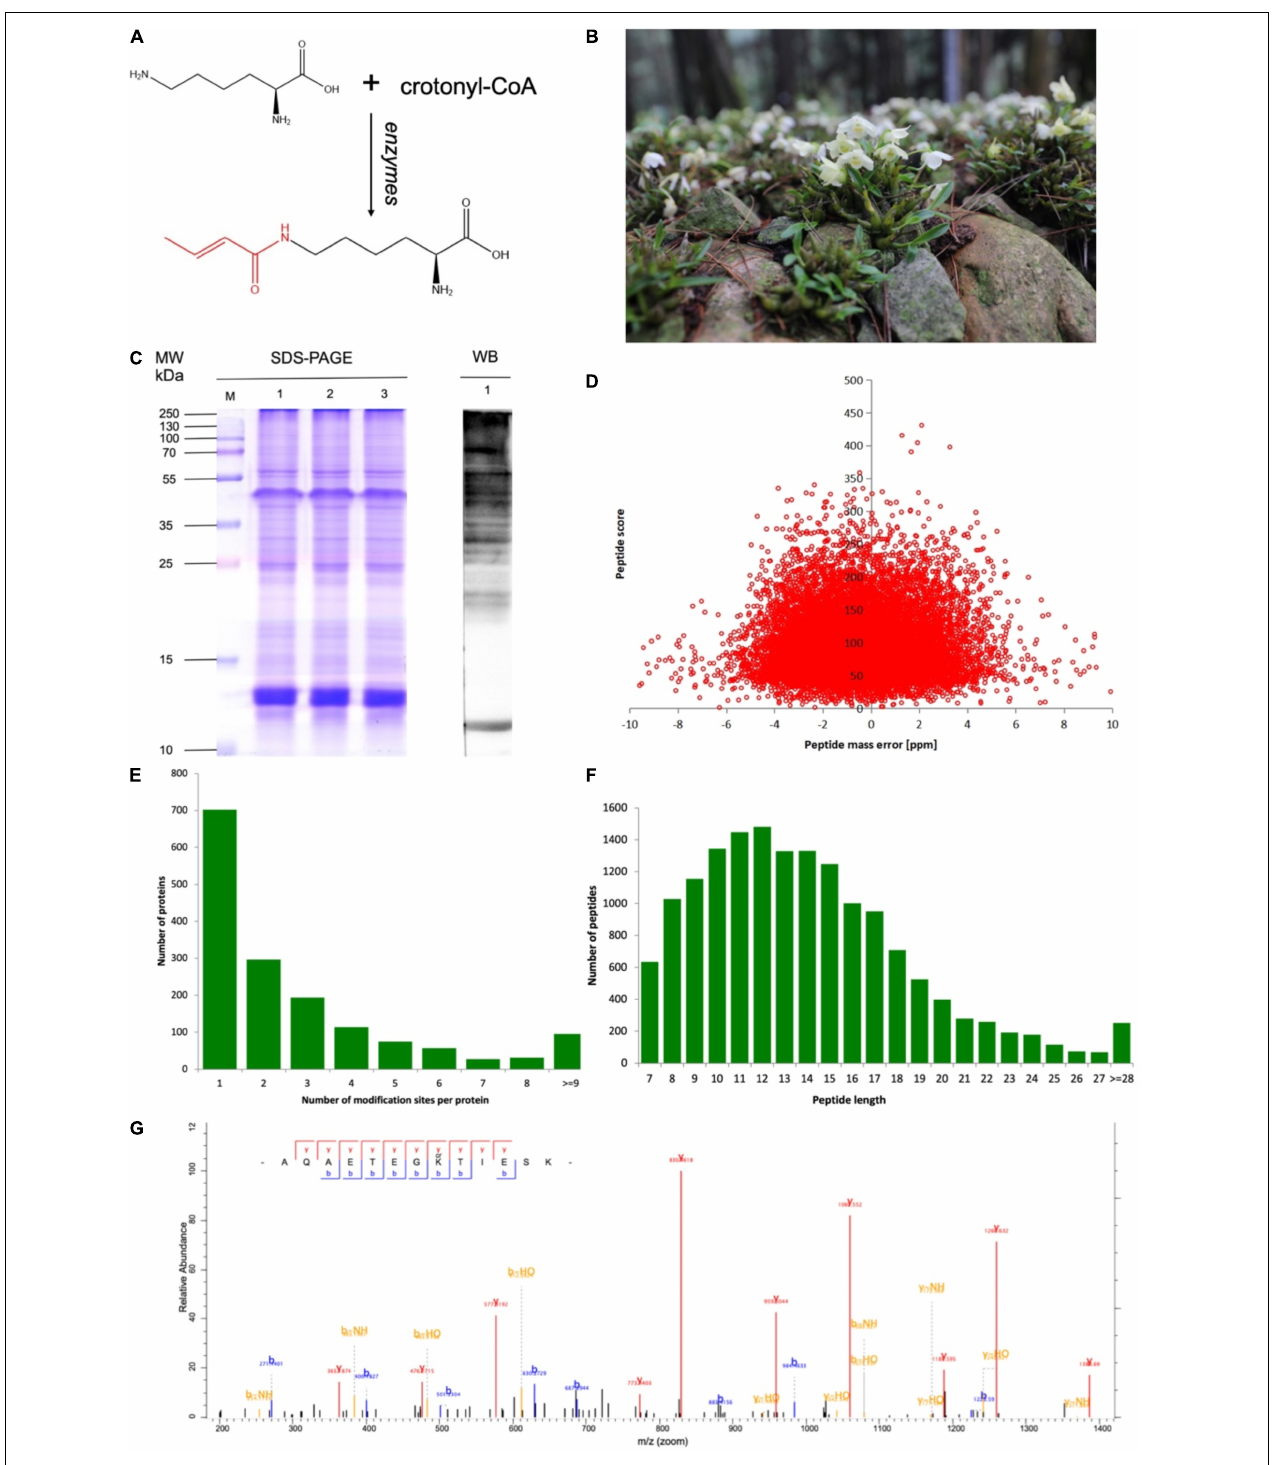
FIGURE 1 | Overview of lysine crotonylation in developing Dendrobium huoshanense . (A) Structure of lysine crotonylation. (B) The picture of an adult D. huoshanense . (C) Western blotting screening of D. huoshanense lysine crotonylome. Molecular weight is labeled on the left. Samples are labeled on the top. 1, 2, and 3 on the left are images of sodium dodecyl sulfate-polyacrylamide gel electrophoresis (SDS-PAGE) stained with Coomassie brilliant blue. 1 on the right is Western blot image. Same amounts of proteins (20 µ g per lane) were loaded for samples. (D) The mass quality precision distributions of crotonylation profiles. (E) Distribution of lysine crotonylation sites in one protein. (F) The peptide length distributions of crotonylation profiles. (G) The mass spectrometry (MS/MS) crotonylated protein spectrum of 60S ribosomal protein L7a.